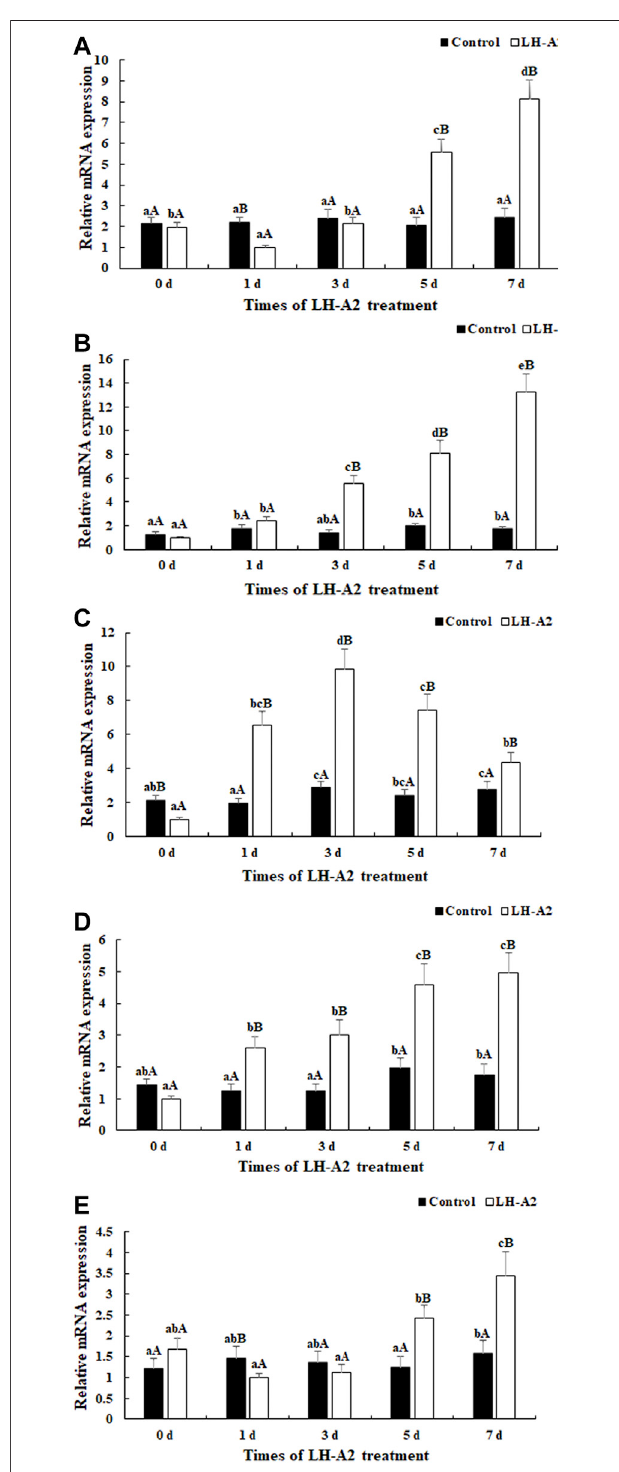
FIGURE 4 | Expression characterization of fi ve DEGs in pituitary at different time points after the LH-A2 treatment. The amount of fi ve DEGs mRNA was normalized to the β -actin transcript level. Data are shown as mean ± SD (standard deviation ) of tissues from three biological replicates. Lowercases indicated the signifcant difference between different